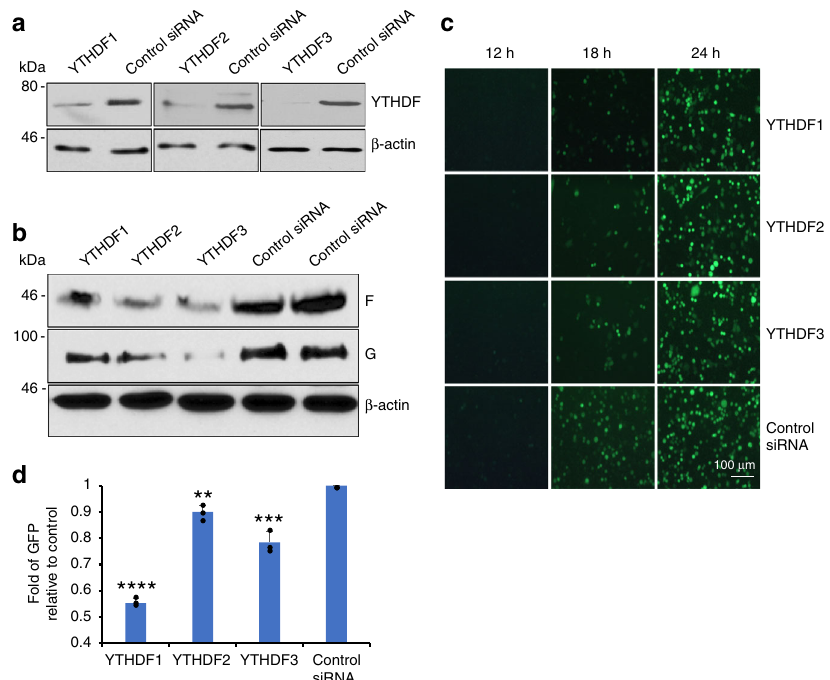
Fig. 3 Knockdown of endogenous YTHDF1, 2, 3 (reader) proteins diminishes RSV gene expression. HeLa cells were transfected with 150 pmole of siRNA targeting YTHDF1, 2, 3 or control siRNA. At 36 h post-transfection, cells were infected with rgRSV at an MOI of 0.5. a Immunoblot analysis of YTHDF1, 2, 3 in HeLa cells transfected with siRNA. b Immunoblot analysis of RSV G and F proteins. c Dynamics of GFP expression in YTHDF1, 2, 3 protein-depleted HeLa cells. Micrographs with ×10 magni fi cation (scale bar of 100 μ m) are shown. d Quanti fi cation of GFP-positive cells by fl ow cytometry at 18 h post- inoculation. Fold of GFP signal compared to the control is shown. Western blots and GFP images shown are the representatives of three independent experiments. Flow cytometry data are expressed as mean of three independent experiments ± standard deviation. The P value (Student ’ s t -test) for YTHDF1, 2, and 3 is **** P = 1.10 × 10 − 6 , ** P = 0.00170, and *** P = 0.000972,